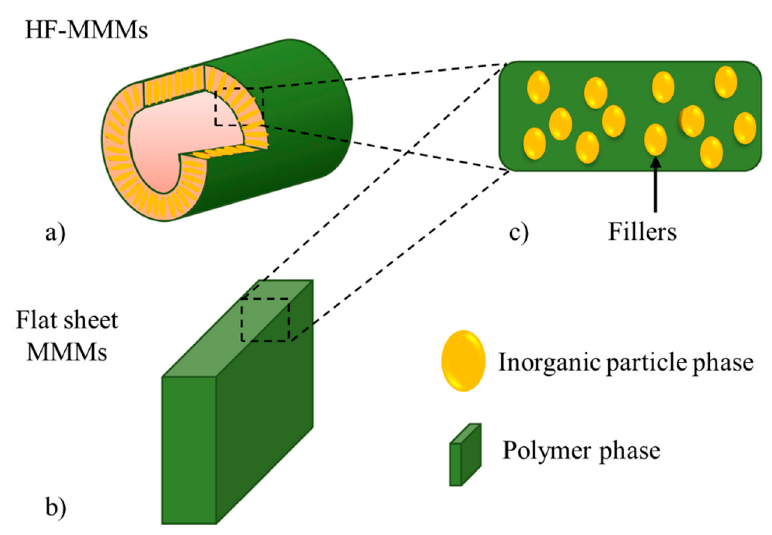
Figure 3. MMM with fillers ( a ) asymmetrical hollow fiber or ( b ) flat sheets. In ( c ), the fillers are homogeneously distributed in the polymer phase.